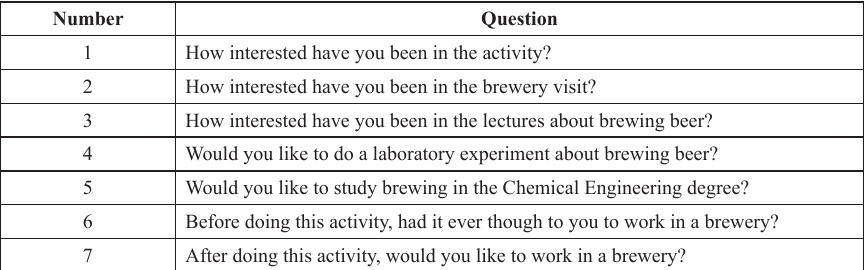
Table 5. Questions of the exploratory